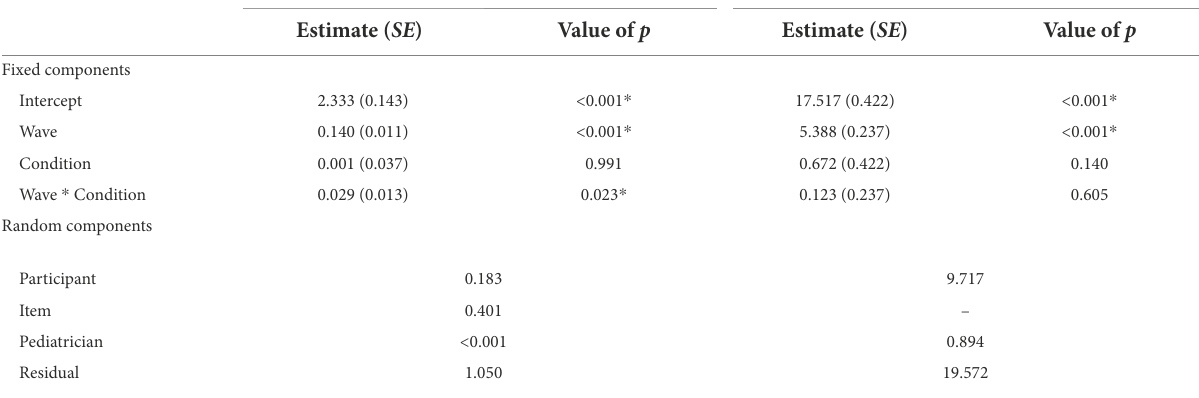
TABLE 2 Estimates from Linear Mixed Effects (LME) models on parent-reported frequency of mathematics-related home activities and children’s early